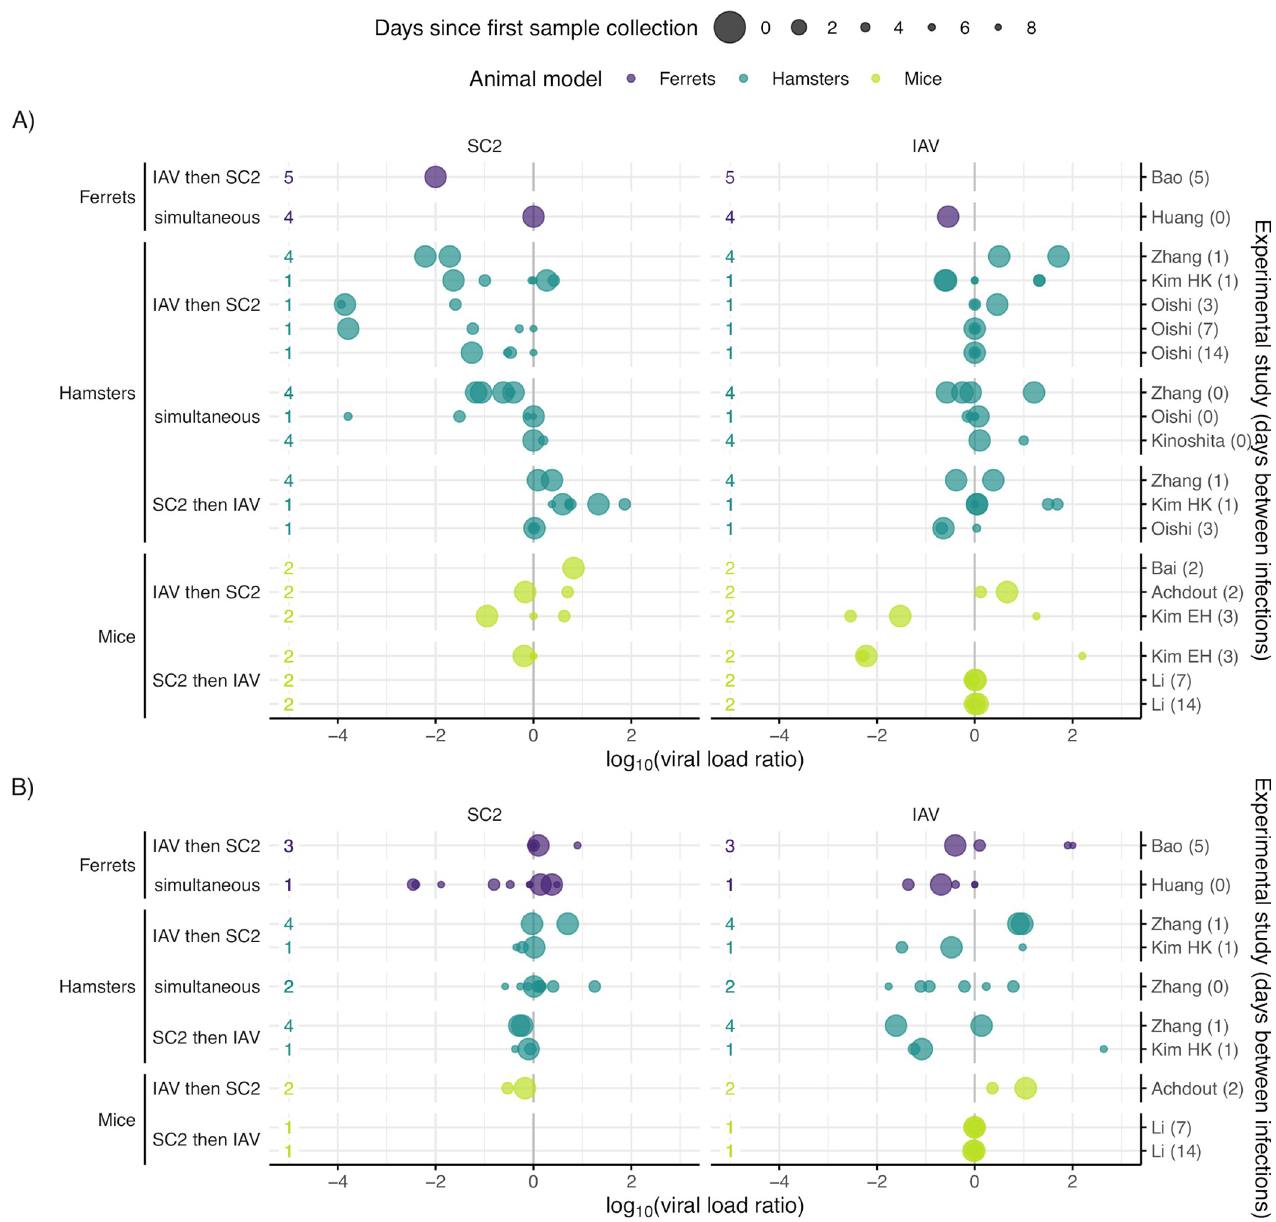
Fig 4. Summary results from animal studies assessing the effect of coinfection with SARS-CoV-2 and influenza A virus (IAV) on viral loads. [44–49,51– 54]. The x -axis values represent the log 10 ratio of the viral load of SARS-CoV-2 (left panels) or IAV (right panels) during coinfection to that during monoinfection, in either the lower respiratory tract (panel A) or the upper respiratory tract (panel B). Every line represents the results of one experiment, whose settings are summarized by four elements: (1) the sequence of infection, indicated by the text on the left y -axis; (2) the time interval between infections, indicated by the number between parentheses on the right y -axis; (3) the time of first sample collection (relative to the time of last infection), indicated by the colored number on the left y -axis; and (4) the times of subsequent sample collection (relative to the time of first sample collection), indicated by the size of the points on the lines. For example, in the study by Kim EH (panel A, mice), the sequence of infection was IAV then SARS-CoV-2 with 3 days separating the infections; the first sample was then collected 2 days after SARS-CoV-2 infection, and then 2 and 5 days after that first sample. The data from every study were extracted from the text, the tables, or the figures; all the corresponding values were checked and are available in S1 and S2 Tables.